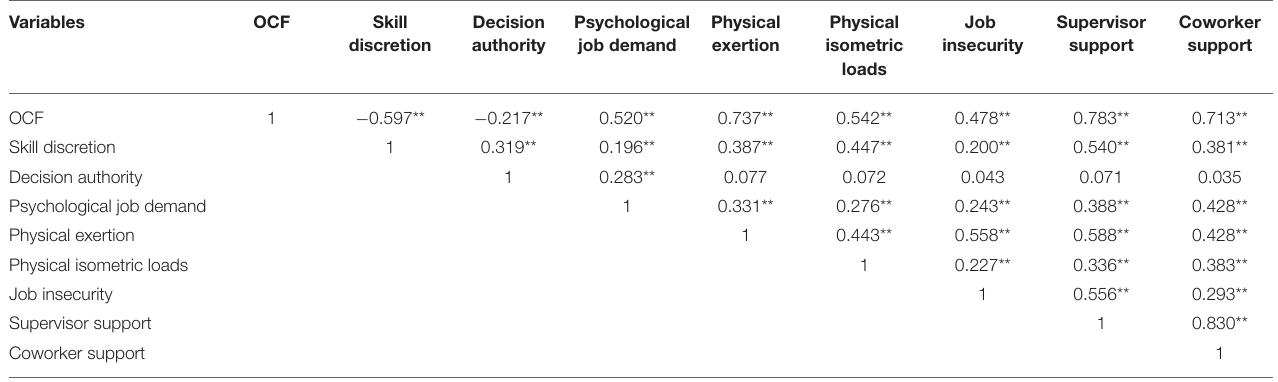
TABLE 5 | Correlation coefficients with Pearsons’ r between JC subscales and